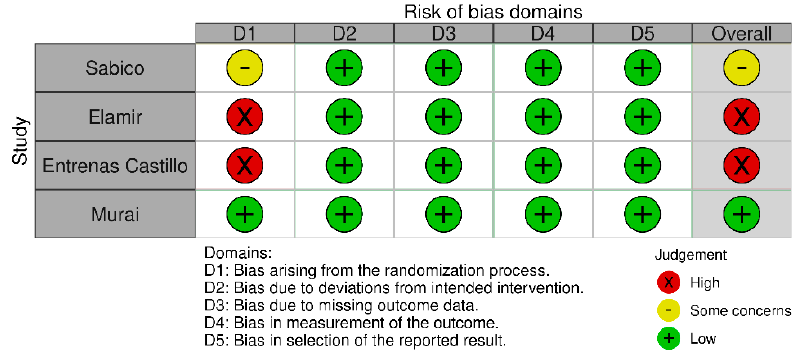
Figure 2. Risk of Bias of Randomized Controlled Trials. Table 3. MINORS Score for non-randomized trials.